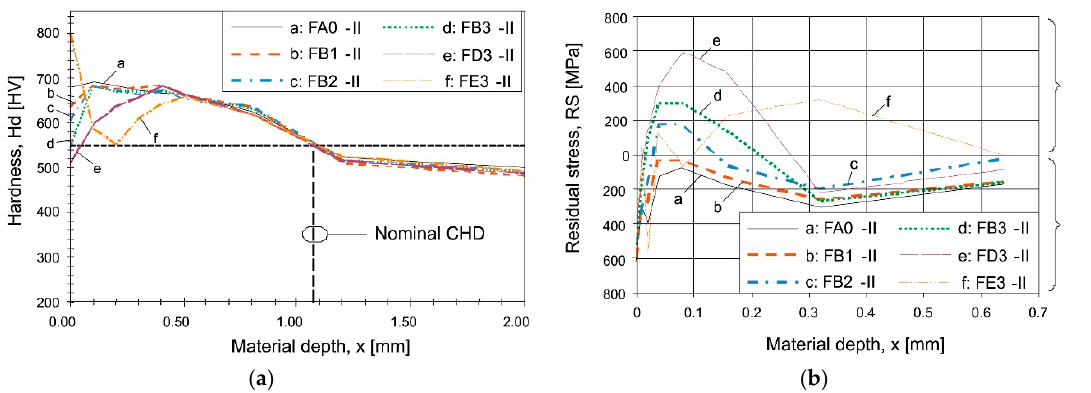
Figure 26. Results of measurements with the calibrated 3MA in gearwheels showing different degrees of grinding damage with designations FA0 ‐ II…FE3 ‐ II: ( a ) hardness profiles and ( b ) residual stress. Table 10. Results of different types of calibration—without and with US parameters.